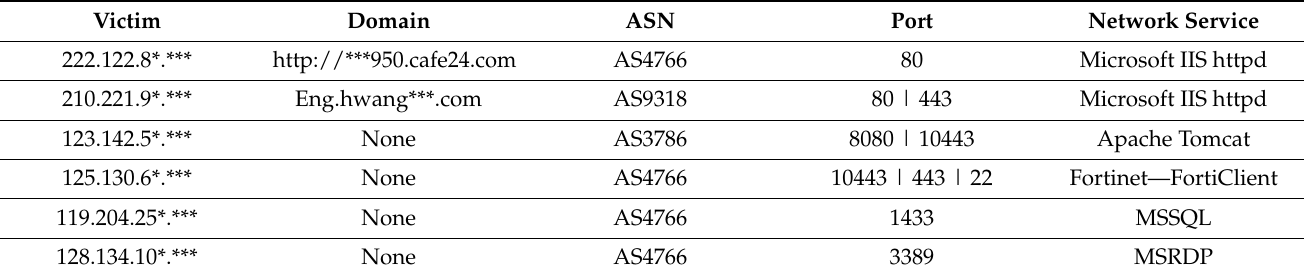
Table 8. Externally exposed network service operating in the victim